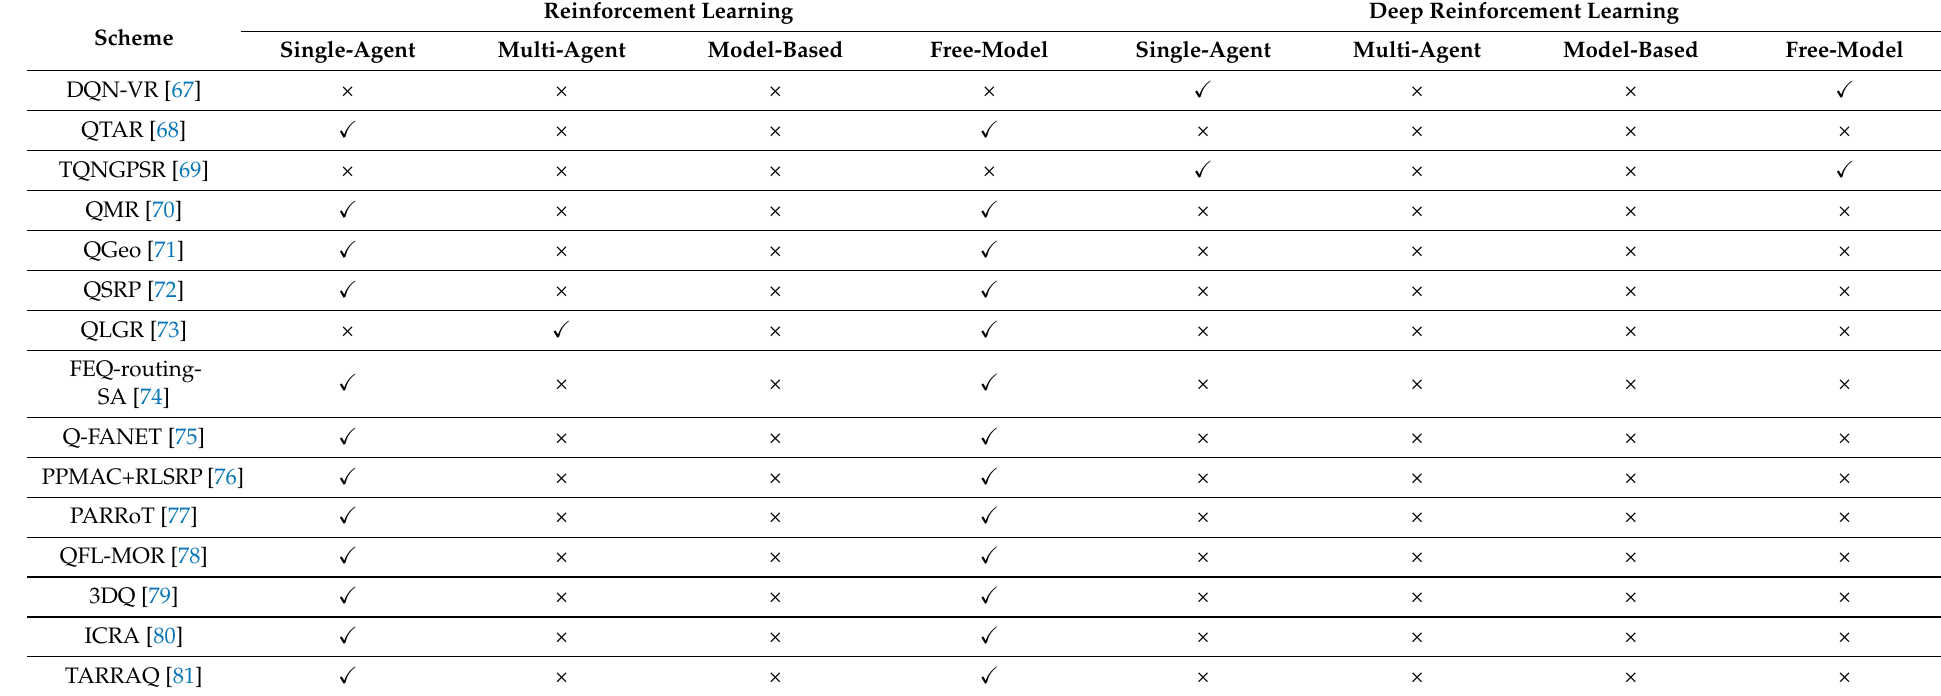
Table 27. Comparison of RL-based routing methods based on learning